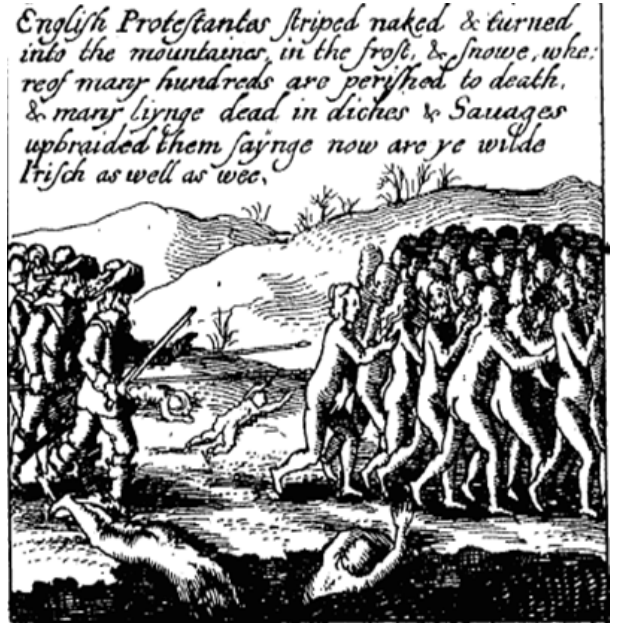
Figure 7. Illustration (perhaps by Bohemian artist Wenceslaus Hol- lar) of alleged atrocities perpetrated by Irish Catholics during the winter of 1641/42; one of multiple such images accompanying the text in Presbyterian clergyman James Cranford’s propagandistic The Teares of Ireland (London, 1642). We thank Jane Ohlmeyer for highlighting this image.